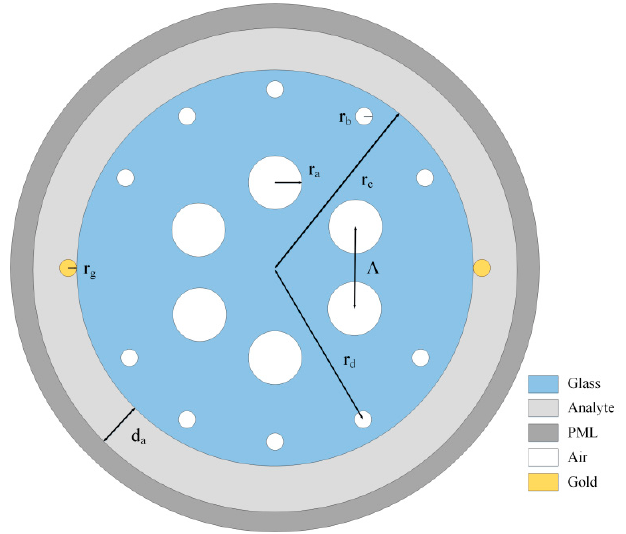
Figure 1. A schematic representation of the sensor structure.